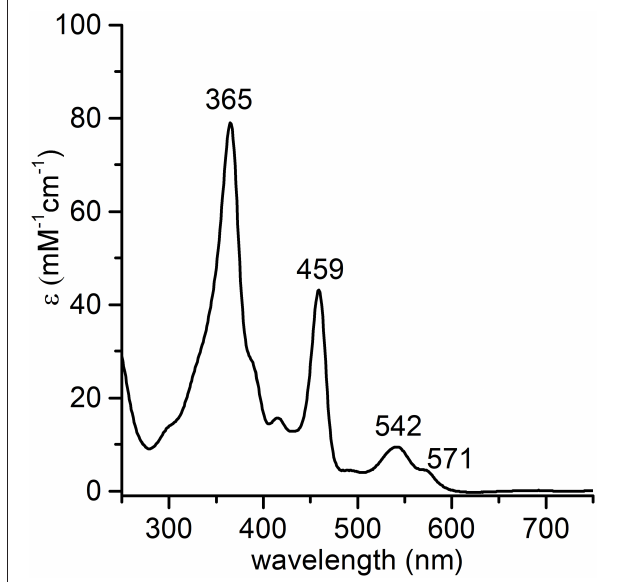
FIGURE 2 | UV-vis absorption spectrum of Mn III -MC6*a (1.0 · 10 − 5 M) in acid aqueous solution (0.1 % TFA v/v , pH